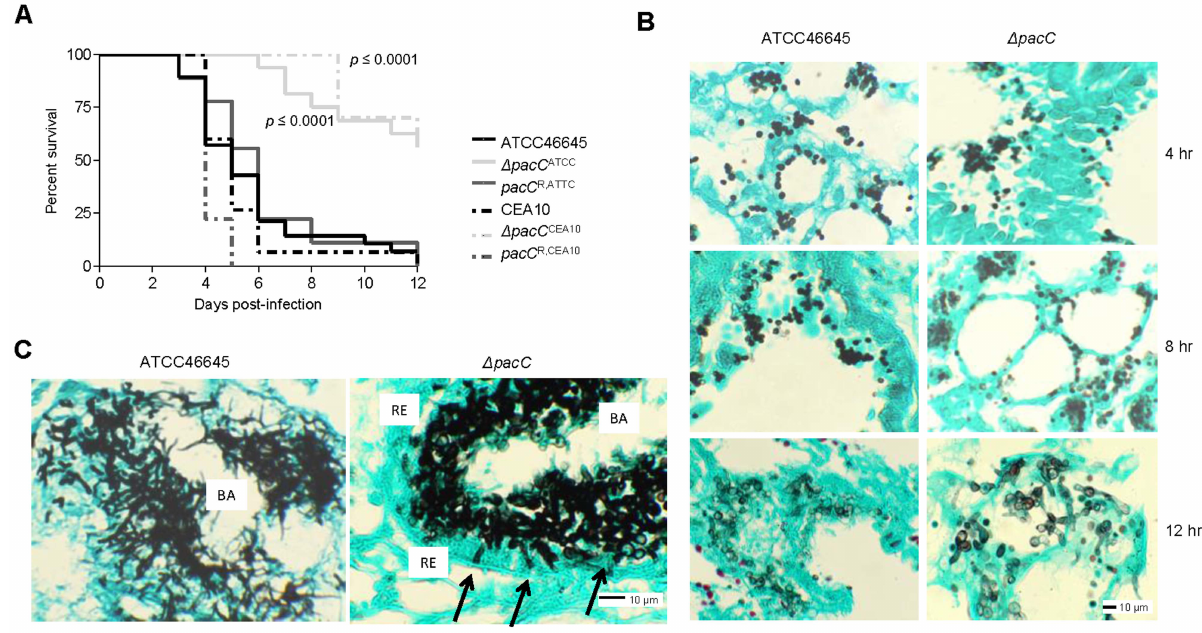
Figure 2. PacC is required for pathogenicity and epithelial invasion in leukopenic mice. (A) Kaplan-Meier curve for murine survival (n $ 9) after infection with 6 6 10 5 and 5 6 10 4 spores for ATCC46645 and CEA10 respectively. (B) Histopathology of leukopenic murine lungs after 4, 8, 12, hr of infection with ATCC46645 and D pacC ATCC (10 8 spores), Grocott’s Methenamine silver (GMS) and light green staining, 200 6 magnification. (C) D pacC ATCC hyphae (black arrows) are unable to penetrate the respiratory epithelium (RE), BA indicates bronchial airway space, 20 hr post-infection, 400 6 magnification. doi:10.1371/journal.ppat.1004413.g002 PLOS Pathogens |